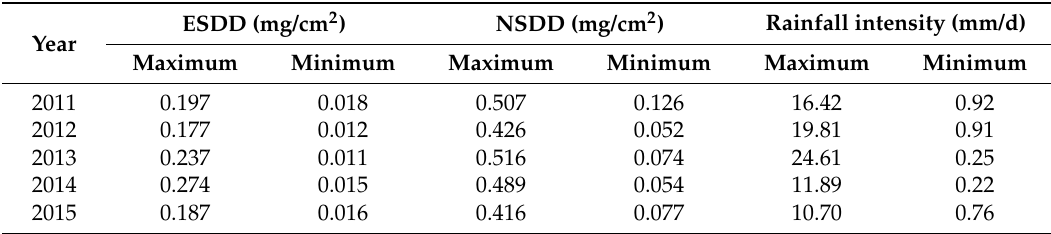
Table 3. The extreme values in Figure 4 (during 2011–2015).